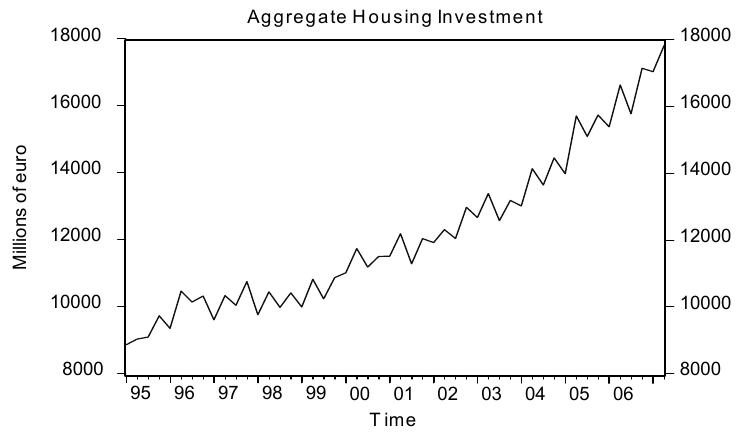
Figure 3 – Aggregate Housing Investment; our elaboration based on NA